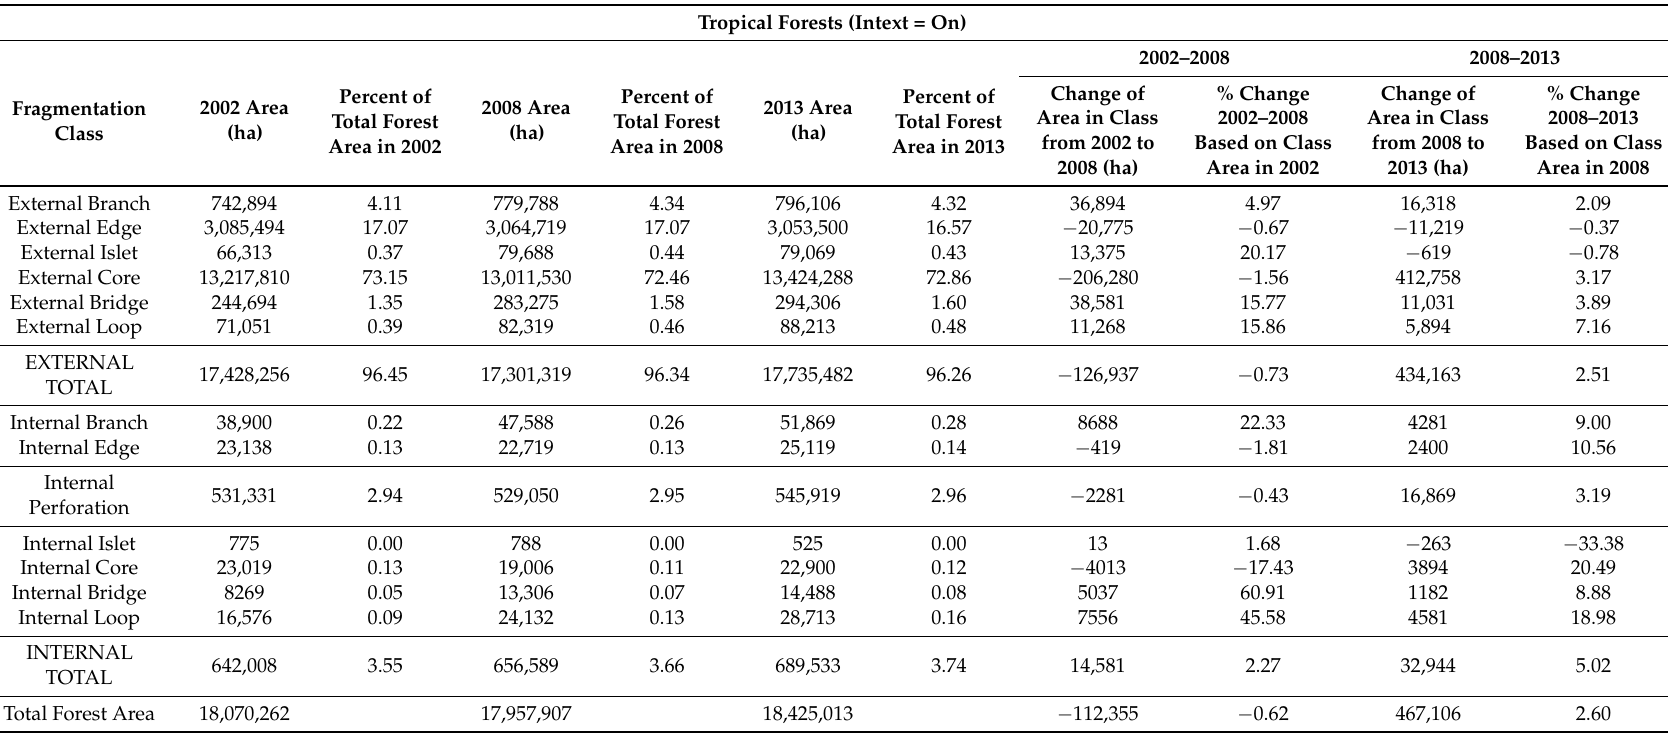
Table 4. Areas in each fragmentation class (intext = “On”) for the tropical forests in 2002, 2008 and 2013. The differences in area and percent changes between dates are presented in the last columns on the right-hand